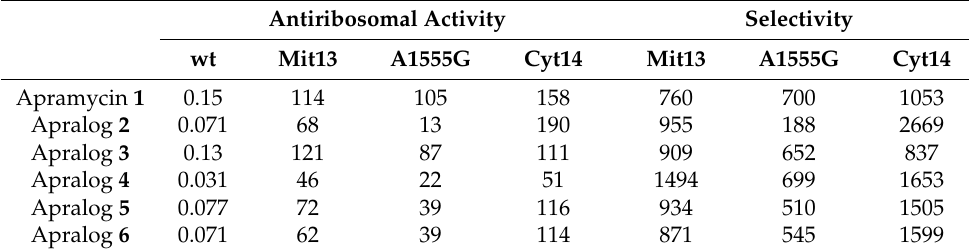
Table 1. Antiribosomal Activities and Selectivities (IC 50 , µ M) a